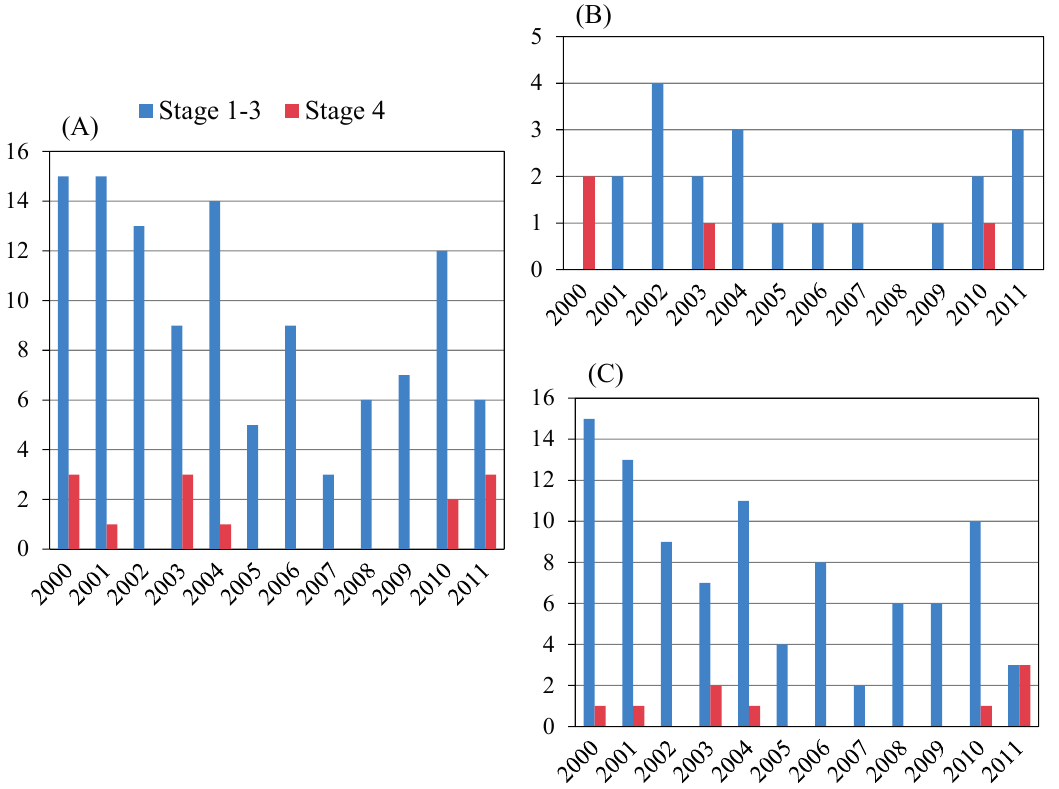
Figure 1. Scheuer stage of primary biliary cirrhosis (PBC) patients in the present study. ( A ) Total patients ( n = 127), Stage 1–3: Stage 4 = 114:13; ( B ) Male patients ( n = 24), Stage 1–3: Stage 4 = 20:4; ( C ) Female patients ( n = 103), Stage 1–3: Stage 4 = 94:9.